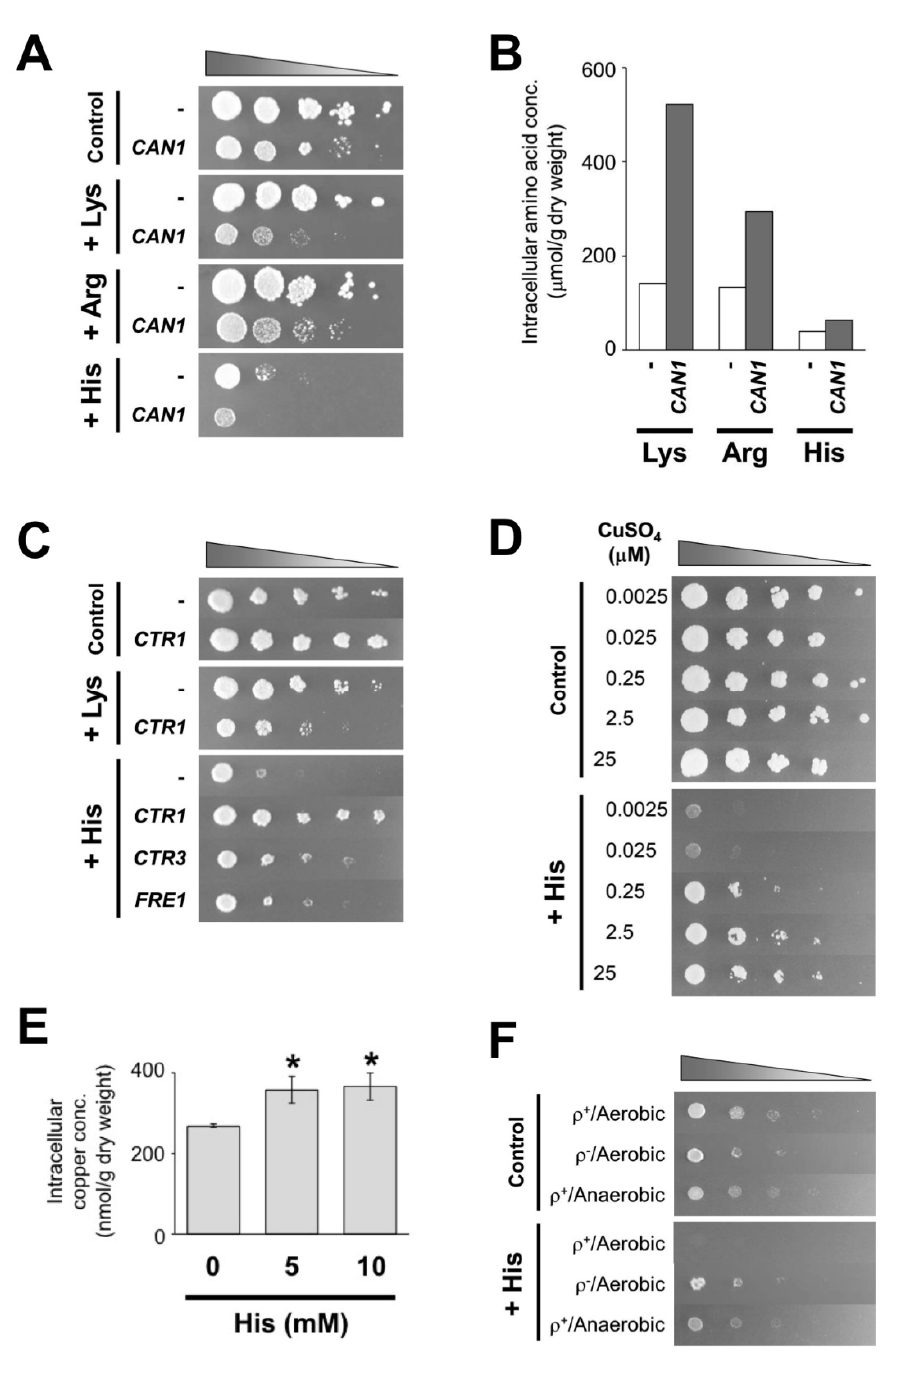
FIGURE 1: The effect of